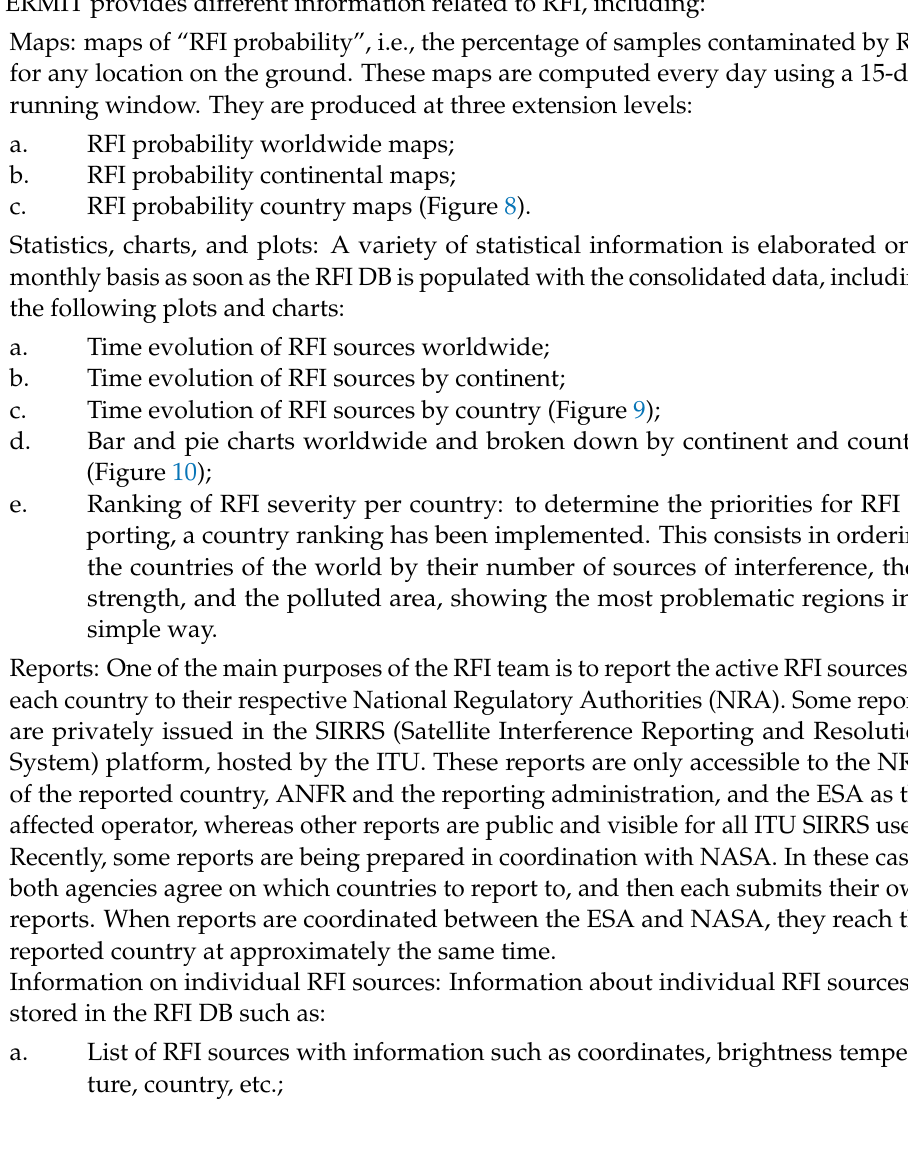
Figure 8. RFI probability map of Guatemala in January 2019 ( left ) and January 2022 ( right ) showing differences before and after reporting and shutting down detected RFI sources.